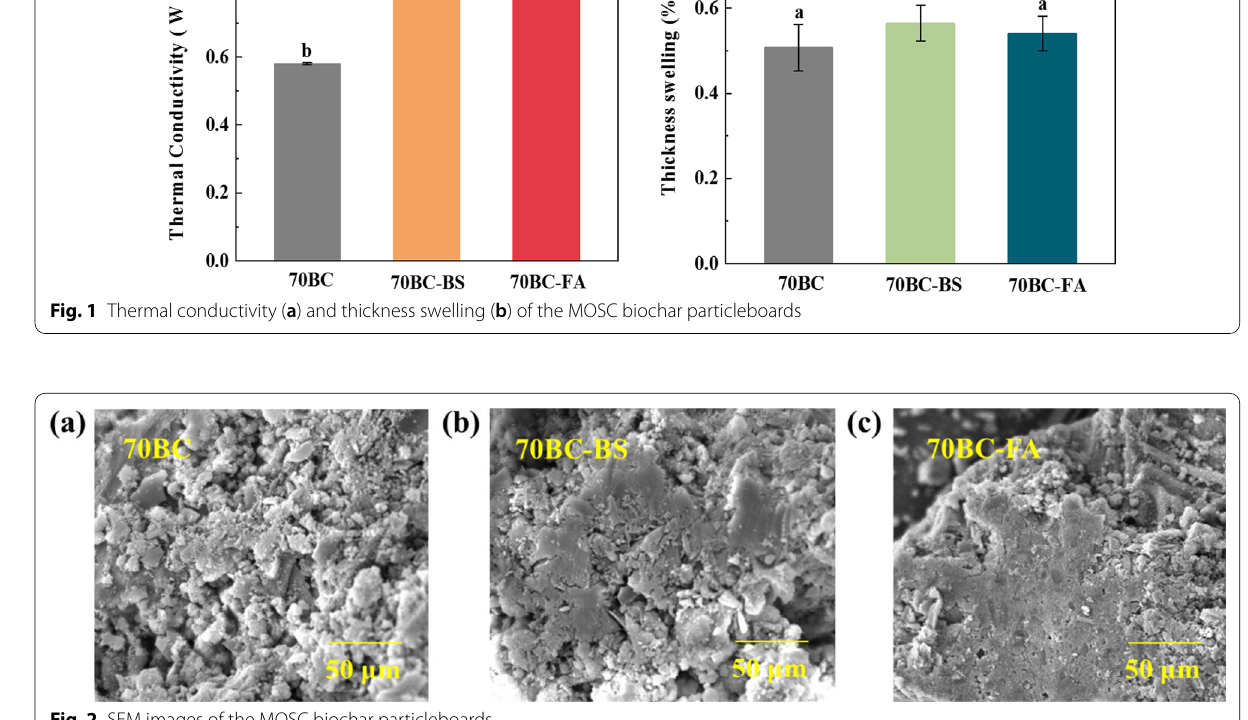
(Fig. 1b) after 24-h water immersion fulfilled the requirement of particleboards (< 2%) while the water absorption rate of biochar MOSC particleboards (Addi- tional file 1: Fig. S3) was reduced with the addition of SCMs. The incorporation of PFA and GGBS unavoid- ably increased the thermal conductivity because the additional amount of hydration products filled in the pores of the particleboards. Compared to the 70BC sample, PFA and GGBS incorporated samples had simi- lar thickness swelling and water absorption rate. As shown in the SEM images (Fig. 2), loose particles can be easily observed on the surface of 70BC-MOSC parti- cleboards, which indicated a loose and weak structure. With the incorporation of GGBS and PFA, a relatively smooth and solid surface could be observed. This was due to the formation of a substantial amount of hydra- tion products, which will be confirmed by the follow- ing TG and XRD analyses, resulting in pore filling and dense structure of the MOSC biochar particleboards. The derivative thermogravimetry (DTG) curves (Fig. 3a) indicate the change in content of hydra- tion products due to the variable addition of SCMs. The decomposition peak at 76 °C was associated with